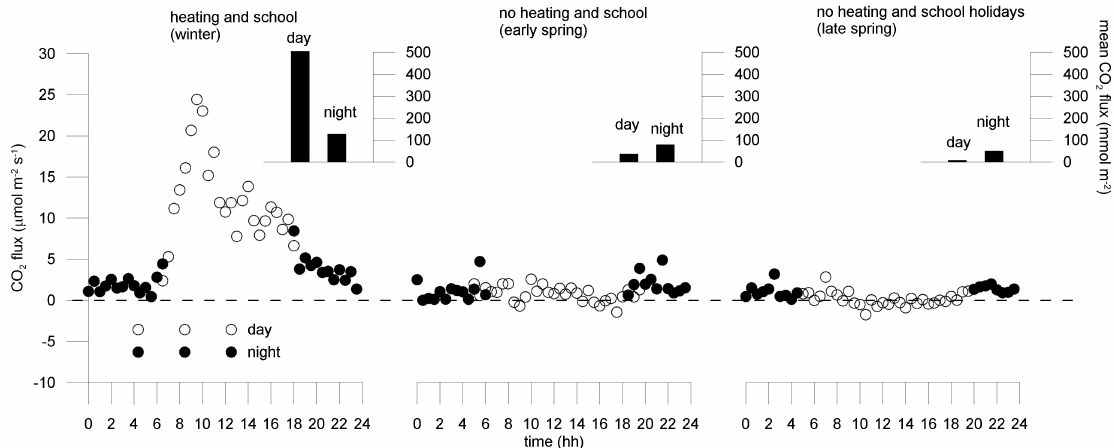
Figure 12. Mean daily course of CO 2 fluxes in three periods: Winter (domestic heating and school activities, on the left panel), early spring (without heating and with school activities, center panel), late spring (without heating and school activities, right panel). In the small corner panels, the cumulated CO 2 fluxes for each period are shown. The standard deviations are around 11.7, 4.3, and 1.0 µ mol m − 2 s − 1 for the left, center, and right panel,